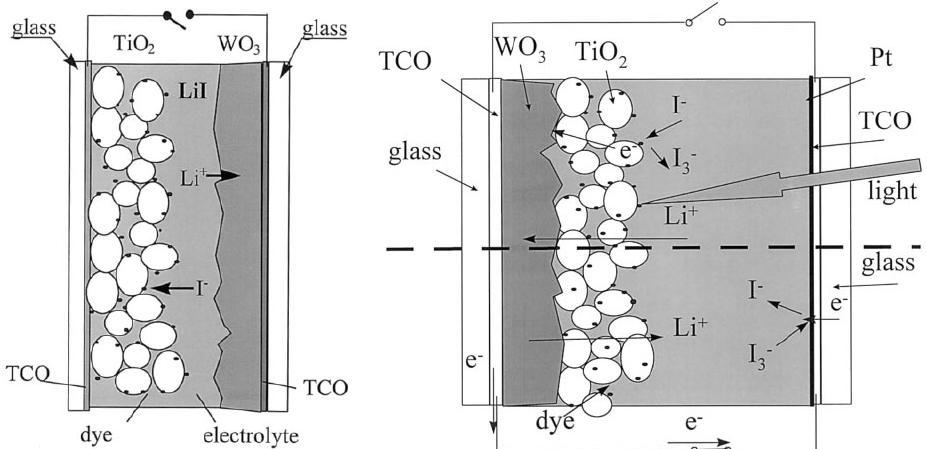
Figure 5. Two different architectures of photoelectrochromic devices: the typical “separated” PECD (left) and the “combined” architecture. Reprinted from Electrochimica Acta, Volume 46, A. Hauch et al., New photoelectrochromic device, Pages 2131–2136, Copyright (2001), with permission from Elsevier.